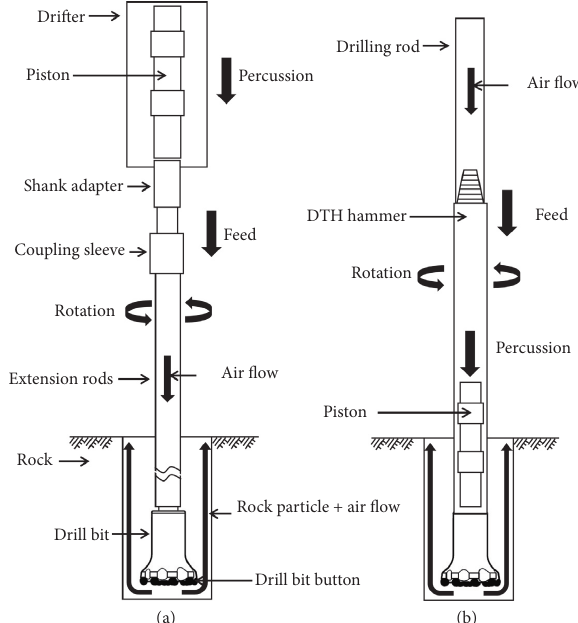
Figure 1: Drilling mechanisms of two types of percussive drilling systems: (a) top-hammer drilling and (b) down-the-hole drilling